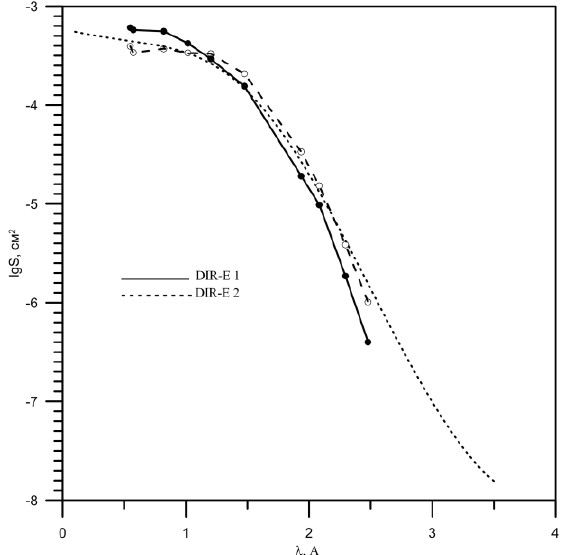
Fig. 2. The results of the calibration devices